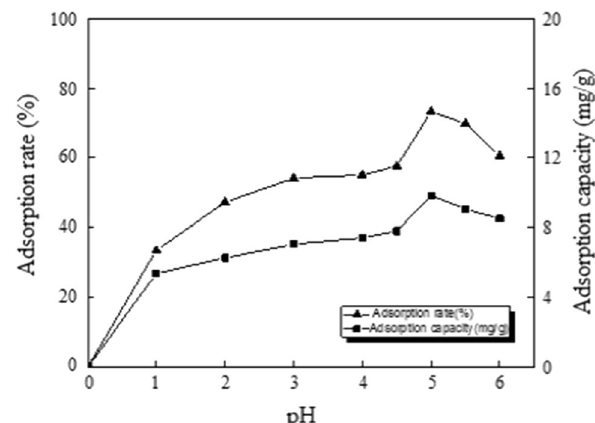
Fig. 5 Effect of pH on cadmium(II) adsorption; m(SBA-15) = 0.10 g, t = 40 min, C Cd 2 + = 1.0 mg/mL, T = 25